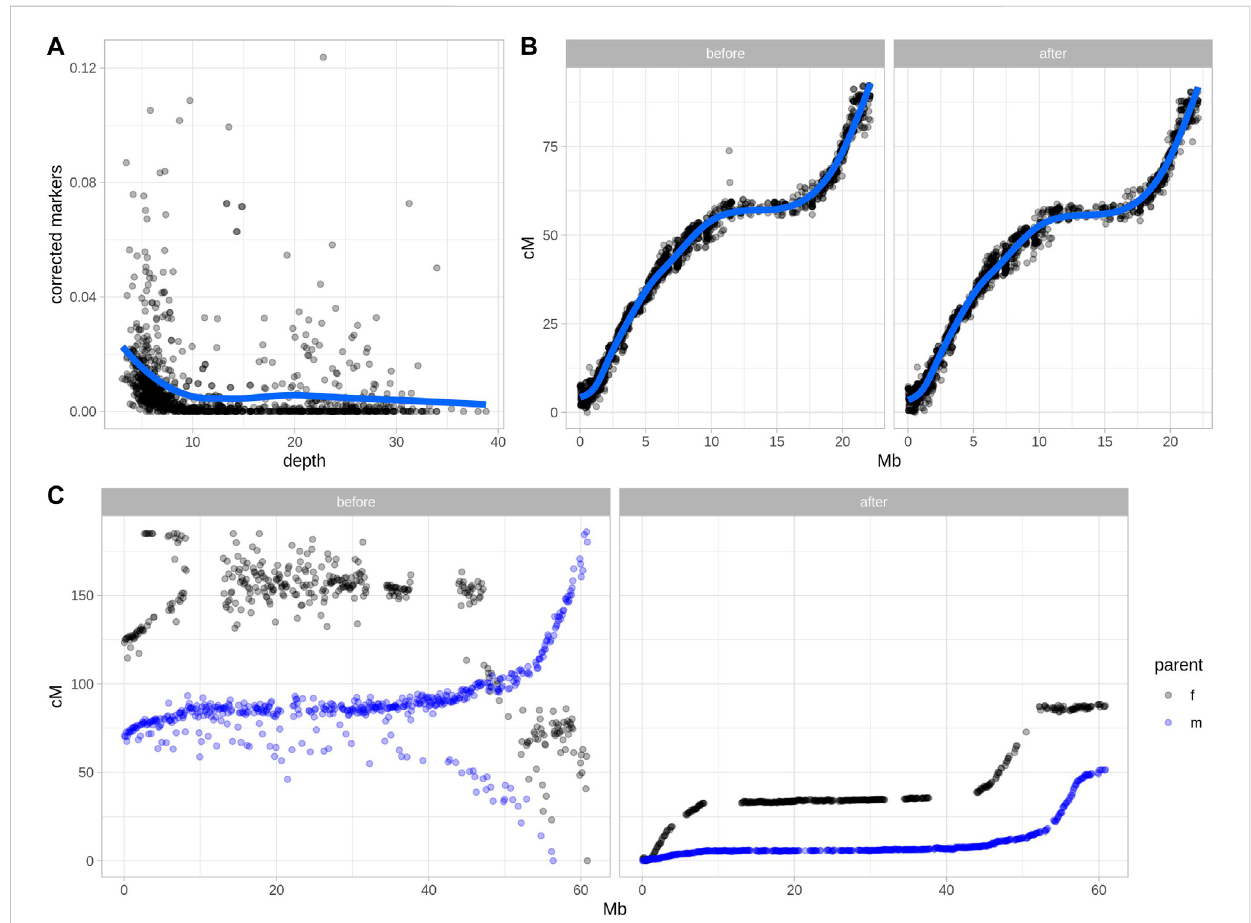
FIGURE 2 Error detection and marker order in two real datasets after applying Smooth Descent. (A) Relationship between sequencing depth and the rate of markers corrected bySmooth Descent foreachchromosome of52individuals ofstrawberry( Fragaria xananassa ). (B) Relationshipbetween physical and geneticpositionsof1,513markersinchromosome15of Ipomoea batatas, beforeandaftercorrecting7.38%ofgenotypecallsusingSmoothDescent. (C) Relationship between physical and genetic positions of 1716 markers in chromosome 12 of Solanum tuberosum, before and after using Smooth Descent to correct low depth genotypes based on a physical